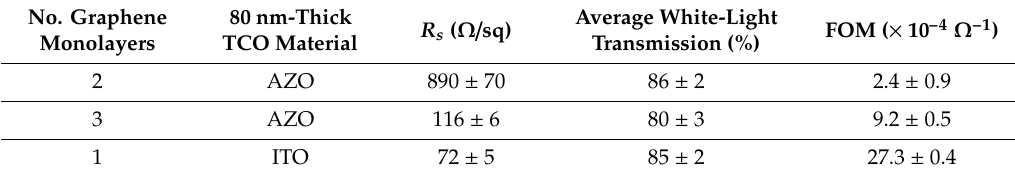
Table 4. Sheet resistance R s , average white-light transmission and figure of merit calculated for the hybrid transparent contacts in study depending on the TCO material and the number of the graphene monolayers transferred.